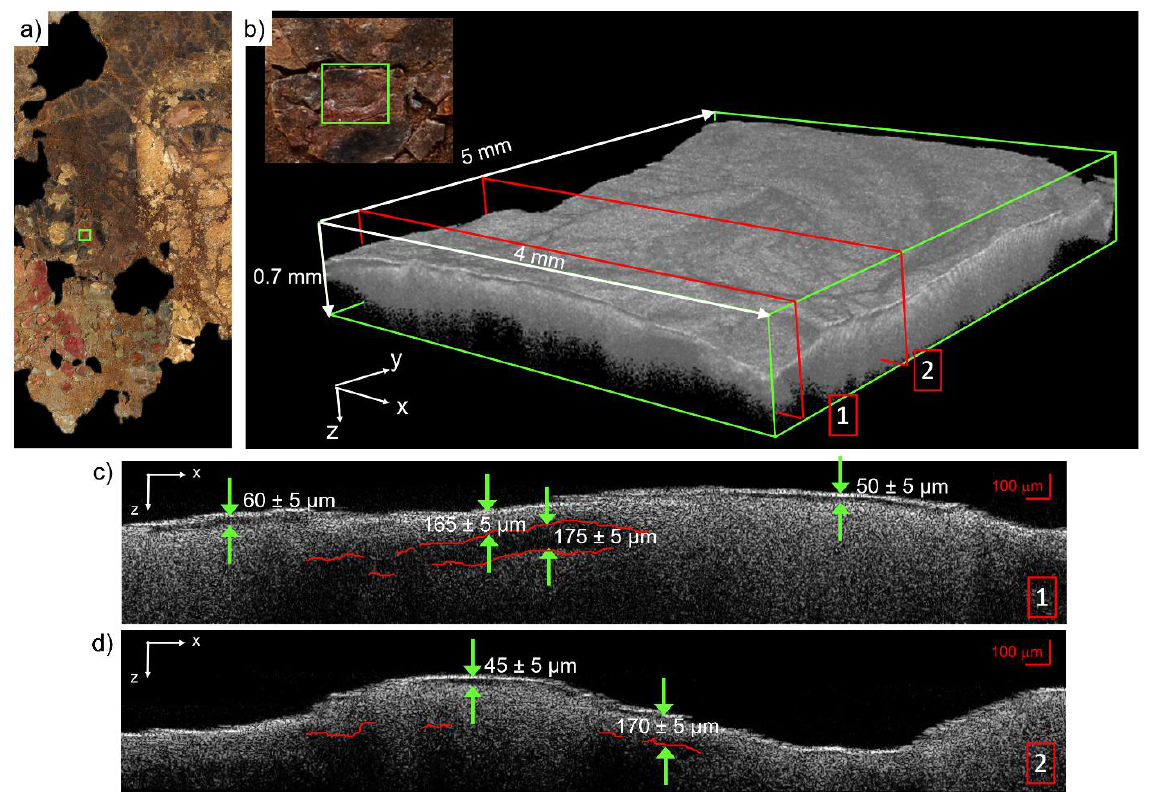
Figure 7. OCT analysis performed on the woman’s right earring: ( a ) RGB image detail showing the acquisition area (green rectangle); ( b ) Tomocube (5 × 4 × 0.7 mm 3 , voxel size 3.5 µ m 3 ) highlighting the position of the z–x sections (red slices 1 and 2) reported in ( c ) and ( d ), respectively. The green arrows point out the distance between different material layers for thickness measurements.